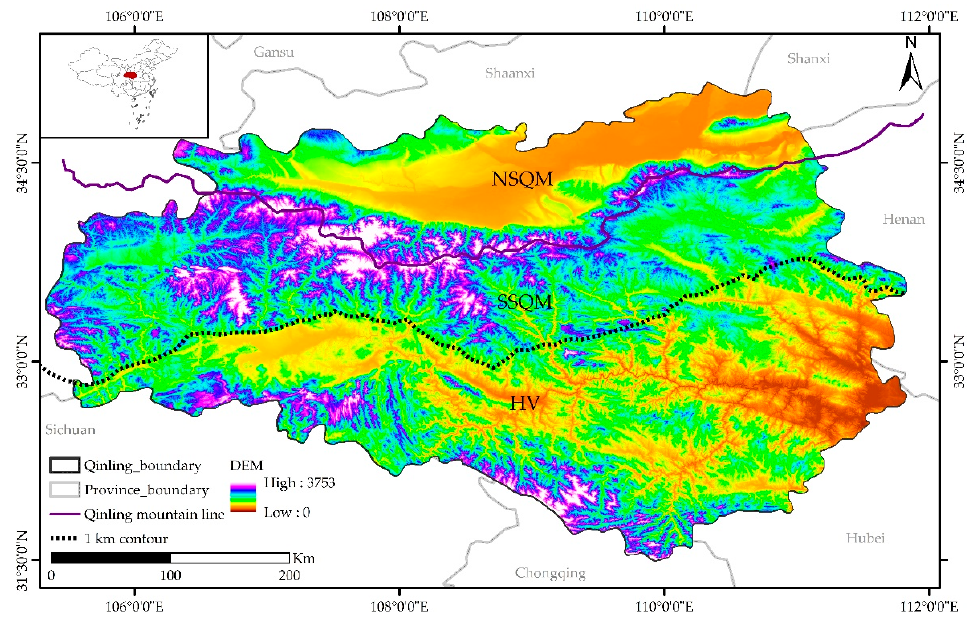
Figure 1. Location of the study site in China and its distribution of evaluation. The 1 km contour represents the contour line located in the south of the Qinling mountain line with an elevation of 1 km. NSQM represents the north slope of the Qinling Mountains (QMS), located in the north of Qinling mountain line. SSQM represents the south slope of QMS, located between the south of Qinling mountain line and 1 km contour. HV represents Hanjiang valley, located in the south of 1 km contour.